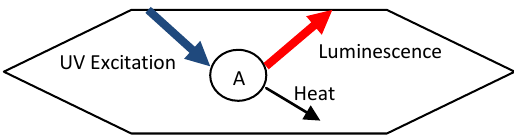
Figure 25. Interactions between excitation energy, impurities and